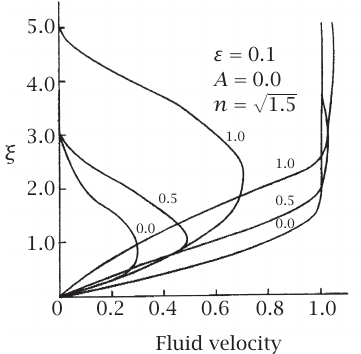
Figure 3.7 . Variations of f/ Ω l and g/ Ω l for different values of the blowing parameter and in absence of A , the magnitude of the fluctuation in blowing velocity.